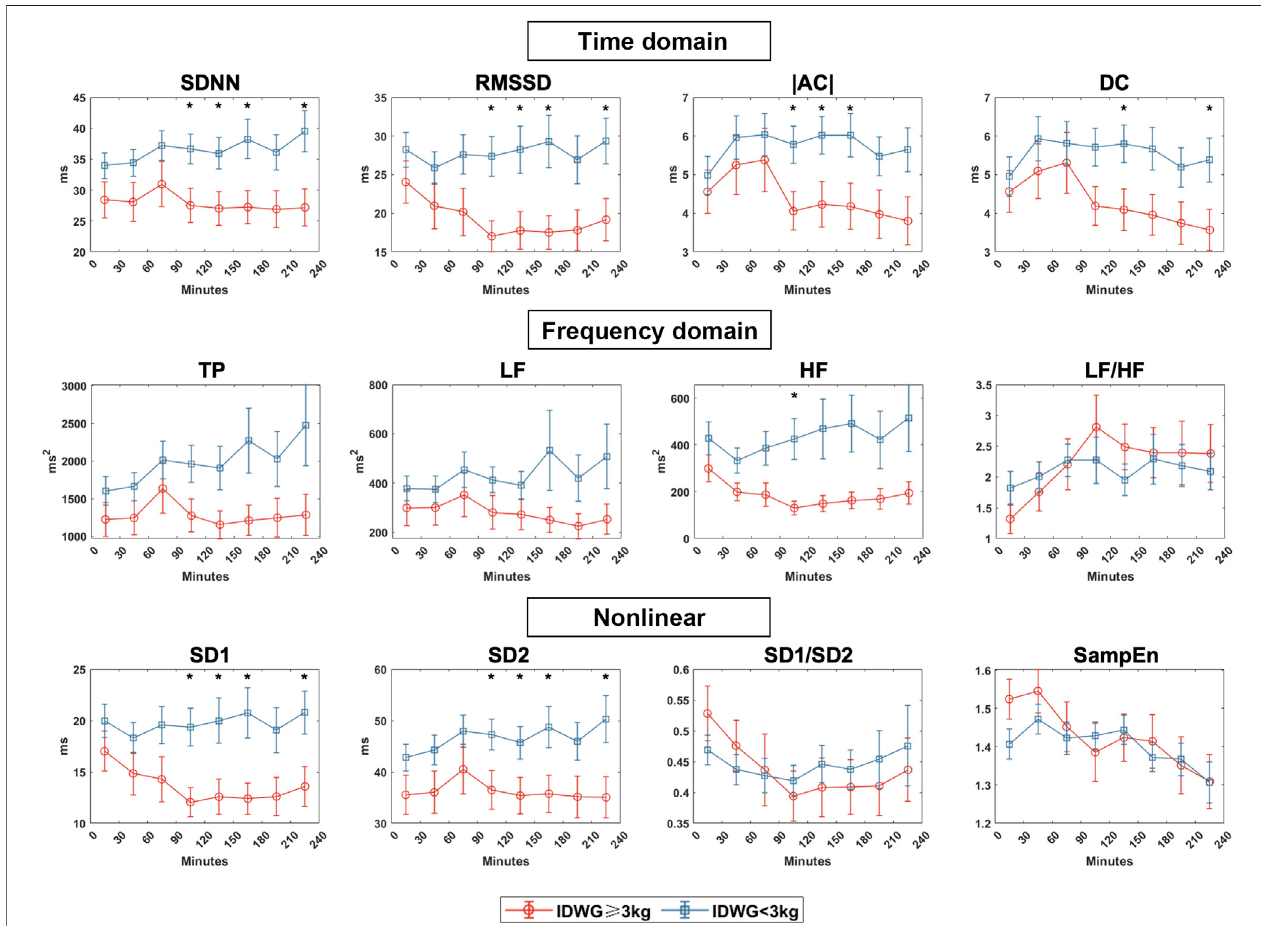
FIGURE 4 | HRV indices between Group A (IDWG ≥ 3 kg) and Group B (IDWG < 3 kg). Representative time domain (SDNN, RMSSD, |AC|, DC), frequency domain (TP, LF, HF, LF/HF), and nonlinear (SD1, SD2, SD1/SD2, SampEn) measurement of HRV between subgroups. Red and blue lines stand for Group A (IDWG ≥ 3 kg) and GroupB(IDWG < 3 kg),respectively. “ * ” stands forstatisticallysigni fi cant( p < 0.05) byStudent ’ sttest betweentwosubgroups.Error bars stand forthestandard errorof the mean (SEM).